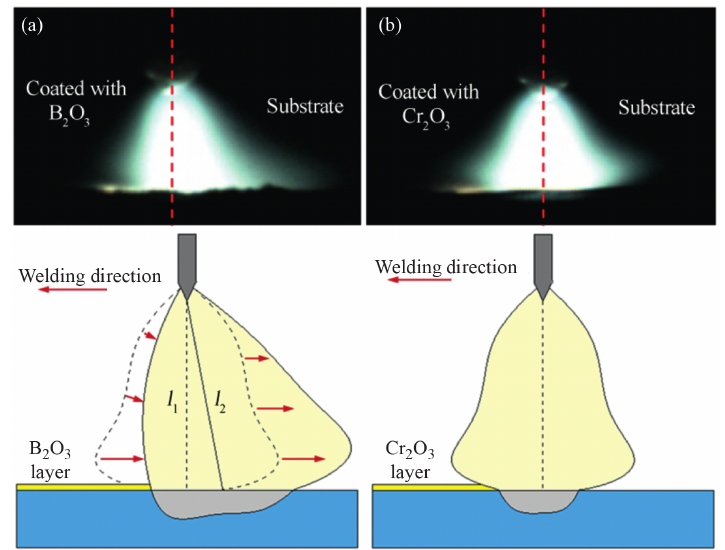
Figure 4: Arc images and schematic diagrams in welding with different flux: (a) A-TIG with B 2 O3; and (b) A-TIG with Cr 2 O 3 .